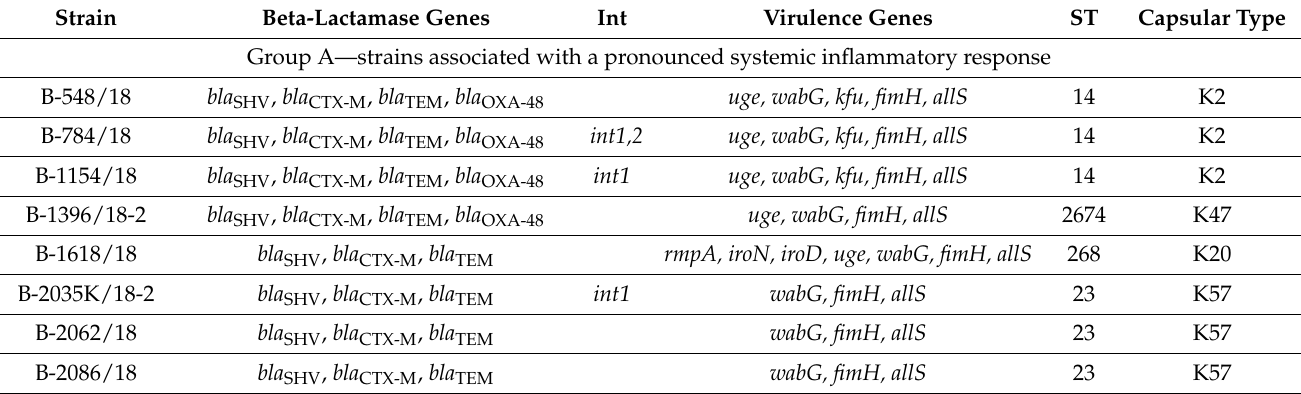
Table 3. Molecular-genetic characteristics of K. pneumoniae strains.